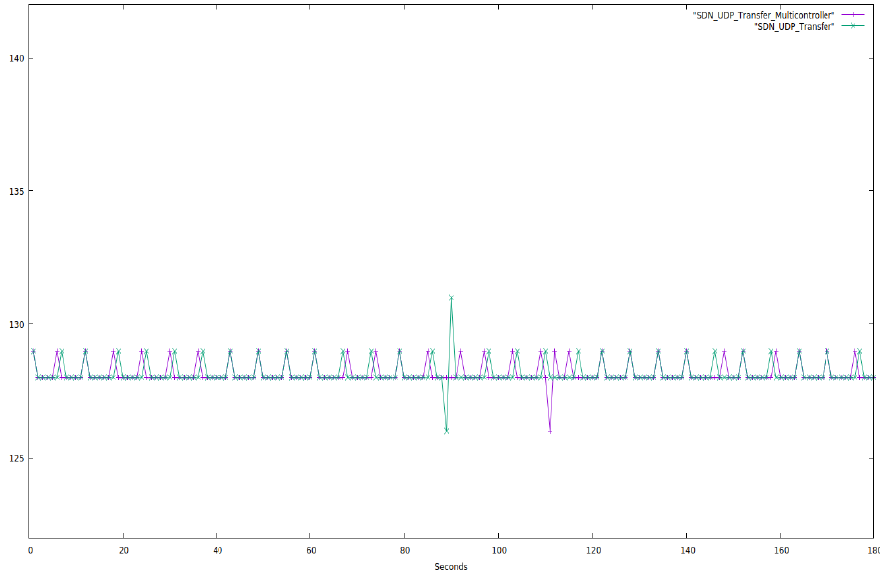
Figure 15. Transfer rate/Throughput of the UDP single-controller SDN vs. Multi-controller SDN.